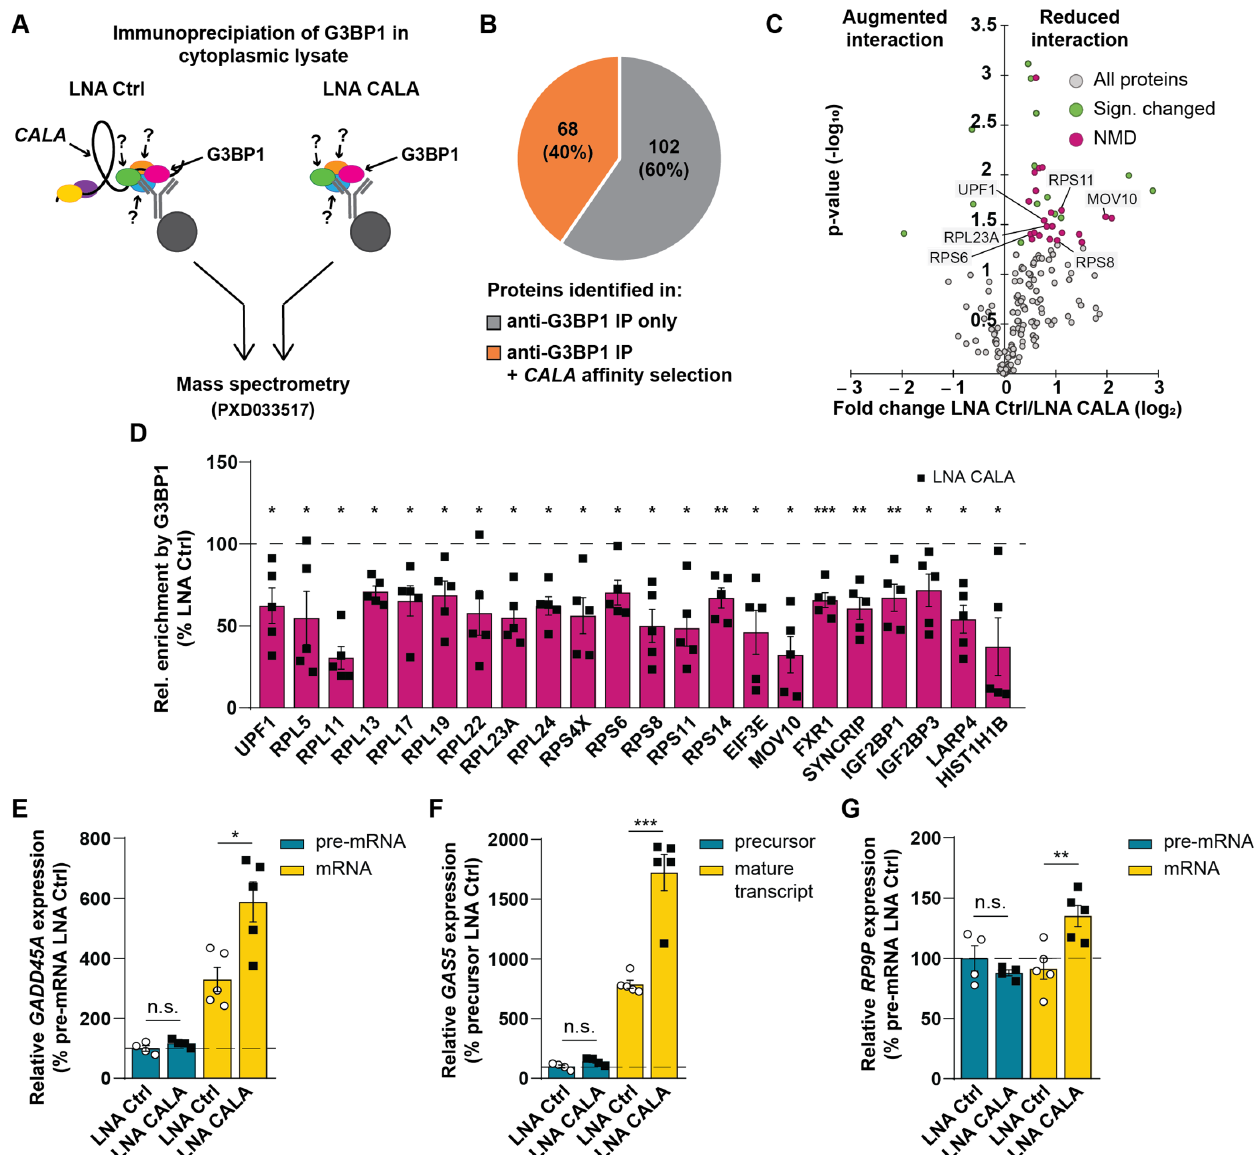
Figure 3. CALA impacts the composition and integrity of cytoplasmic G3BP1-RNPs driving mRNA decay. ( A ) Schematic representation of CALA -G3BP1-complex identification by anti-G3BP1 immunoprecipitations and mass spectrometry in control and CALA -silenced HUVECs. ( B ) Proportion of proteins identified exclusively in anti-G3BP1 IPs and overlapping with CALA antisense affinity selections. ( C ) G3BP1-co-immunoprecipitated proteins upon CALA silencing, discriminating augmented and reduced interactions. Nonsense-mediated decay (NMD) associated proteins were identified using Metascape. ( D ) Relative association of NMD proteins with G3BP1 in CALA -silenced HUVECs (n = 5). ( E – G ) Relative expression of ( E ) GADD45A , ( F ) GAS5 , and ( G ) RP9P pre-mRNA and mRNA upon silencing of CALA determined by RT-qPCR (n = 5). Data information: In ( G ) data are represented as means ± SEM and derive from independent biological replicates, * p < 0.05, ** p < 0.01, *** p < 0.001, n.s.: non-significant. ( C – E , G ): two-tailed unpaired t -test, ( D , F ): Mann-Whitney U